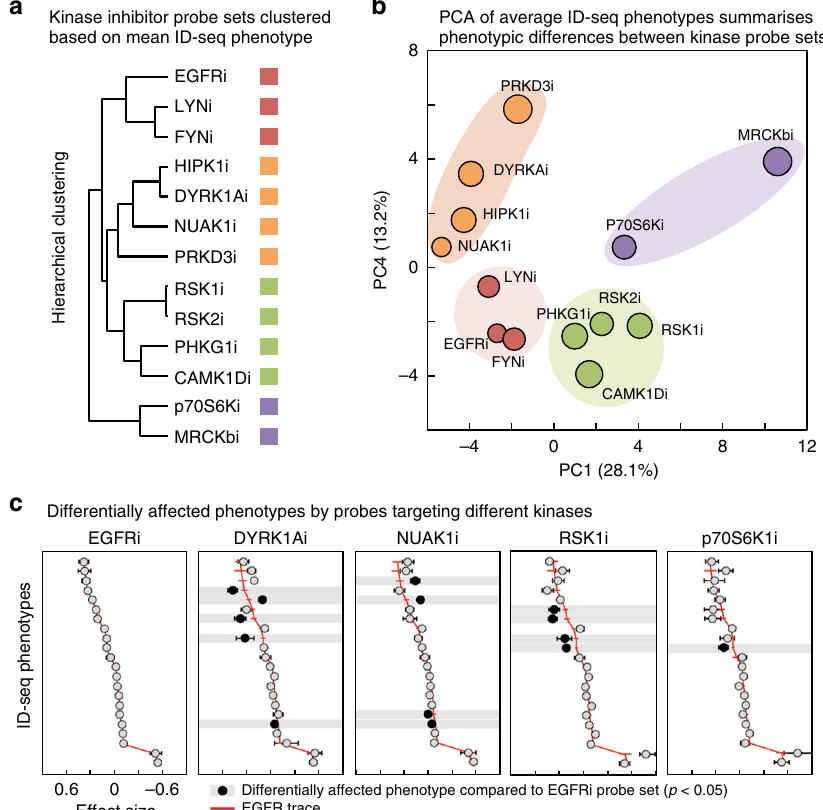
Fig. 5 Enriched kinase inhibitor probe sets show differentially affected molecular phenotypes. a K -means clustering of mean probe effect on molecular phenotypes per kinase probe set. b Principal component analysis on mean probe effects shows in PC1 and PC4 distinct kinase probe-set clusters. Colours based on K -means clustering of the data (see a ). c The mean and standard error of probe effect on molecular phenotypes, per probe set inhibiting kinases EGFR, DYRK1A, NUAK1, RSK1/2/3/4 and p70-Ribosomal S6 kinase. Compared to EGFR the other four kinases have a comparable phenotypic pro fi le with several changes different effects on molecular phenotypes (black nodes, p < 0.05, t -test)